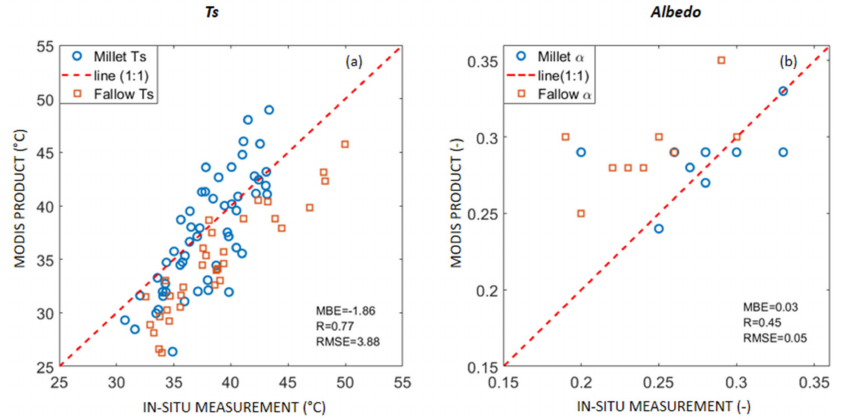
Figure 5. Scatterplot of: MODIS Ts ( a ); and α ( b ) versus in-situ data (only millet and fallow sites are considered).